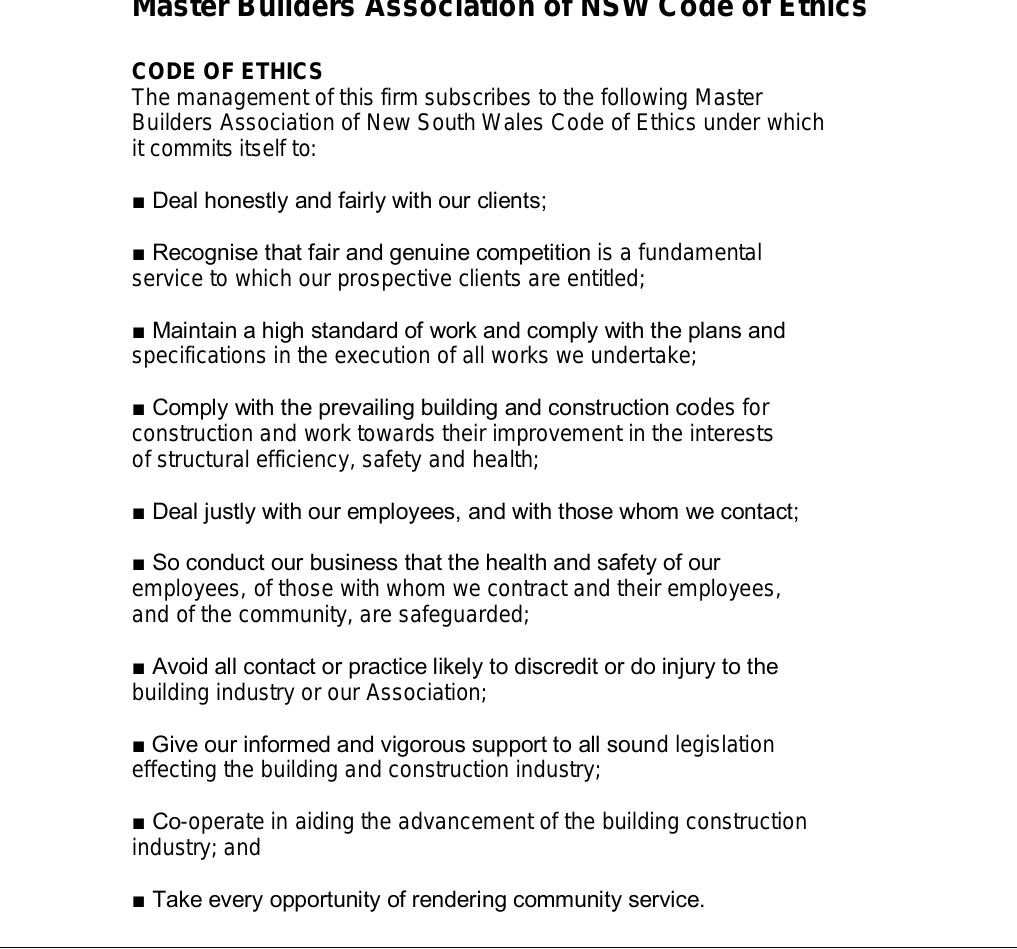
Figure 3 The MBA NSW Code of Ethics (reproduced with permission 5 March